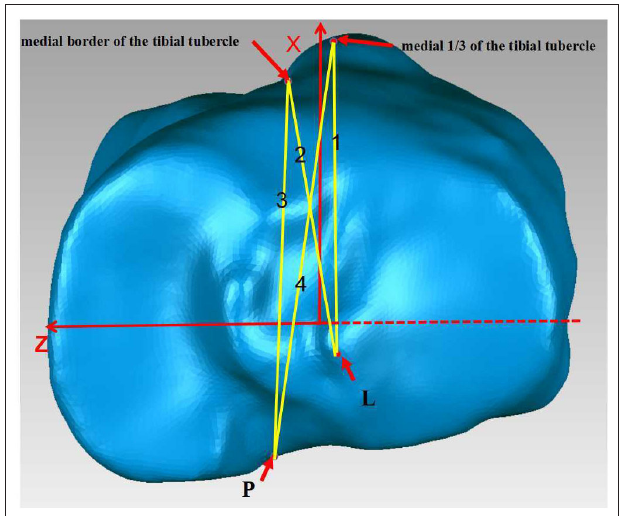
FIGURE 3 | Definition of the TPA: the intersection angle of the M-L line with the Z-axis.